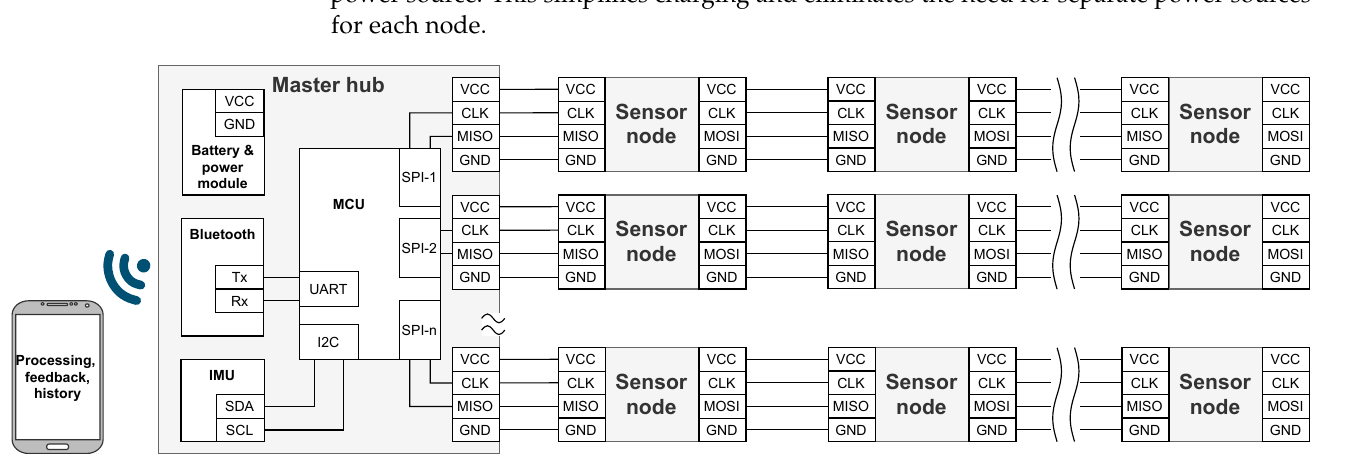
Figure 4. The architecture of sensor network for motion tracking system.